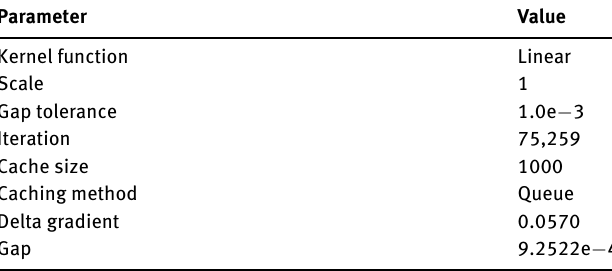
Table 2: Specifications of